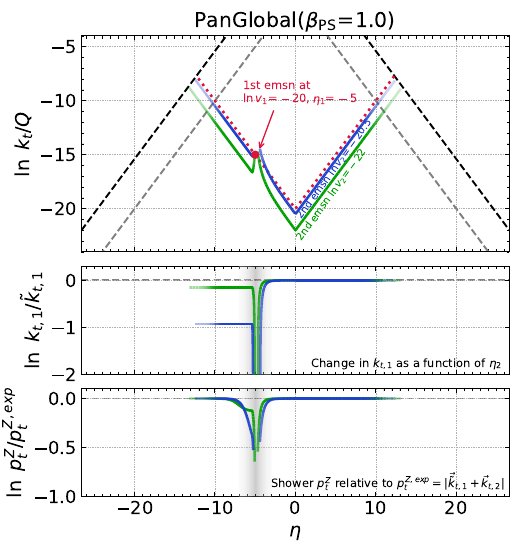
Figure 4. Same as figure 2, but for PanGlobal with β ps = 1 and η 1 = − 5